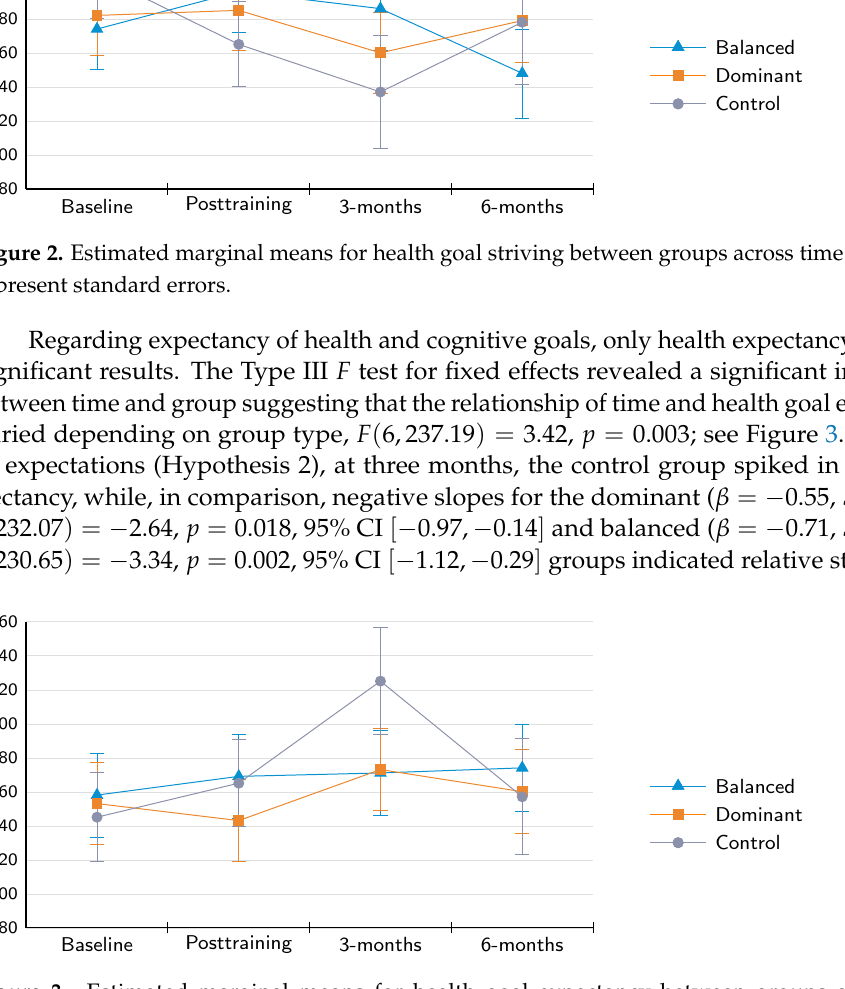
Figure 3. Estimated marginal means for health goal expectancy between groups across time. Error bars represent standard